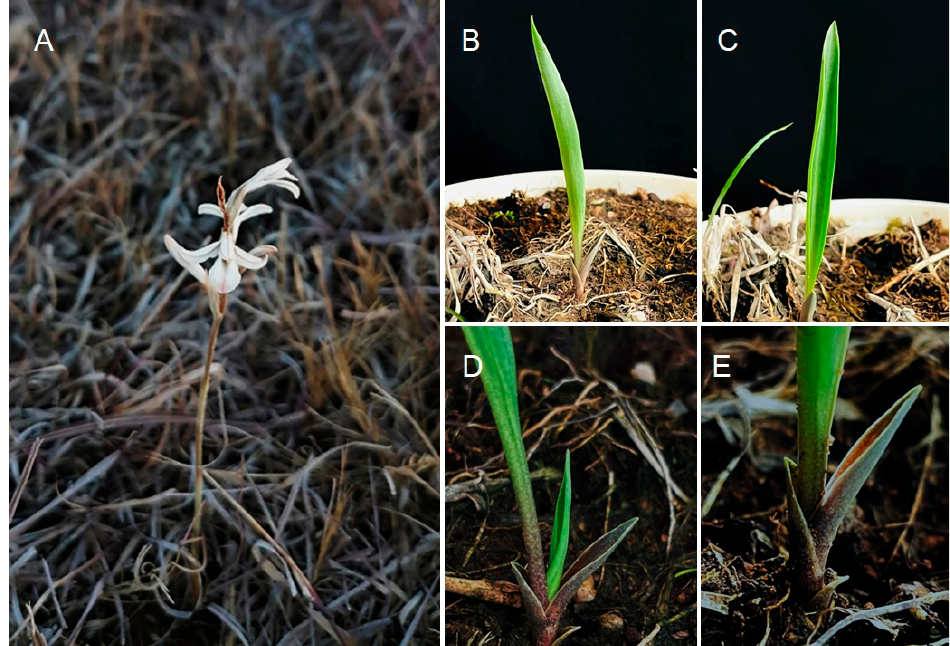
Figure 1. Schiedeella bajaverapacensis —living plant: ( A ) in situ, in the flowering stage; ( B – E ) ex situ, in the leafy stage. Photo. O. Alvarado ( A ), F. Archila ( B – E ).